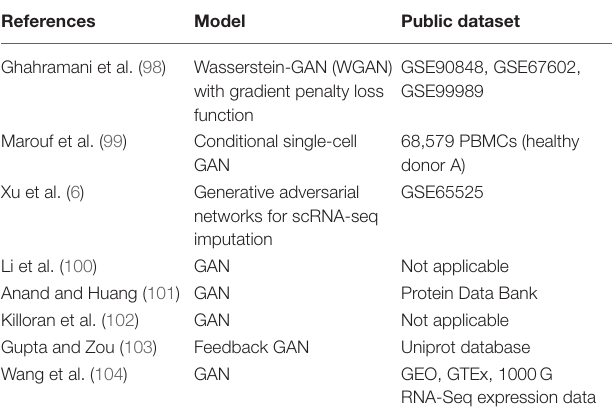
TABLE 4 | Literatures for the application of GAN in